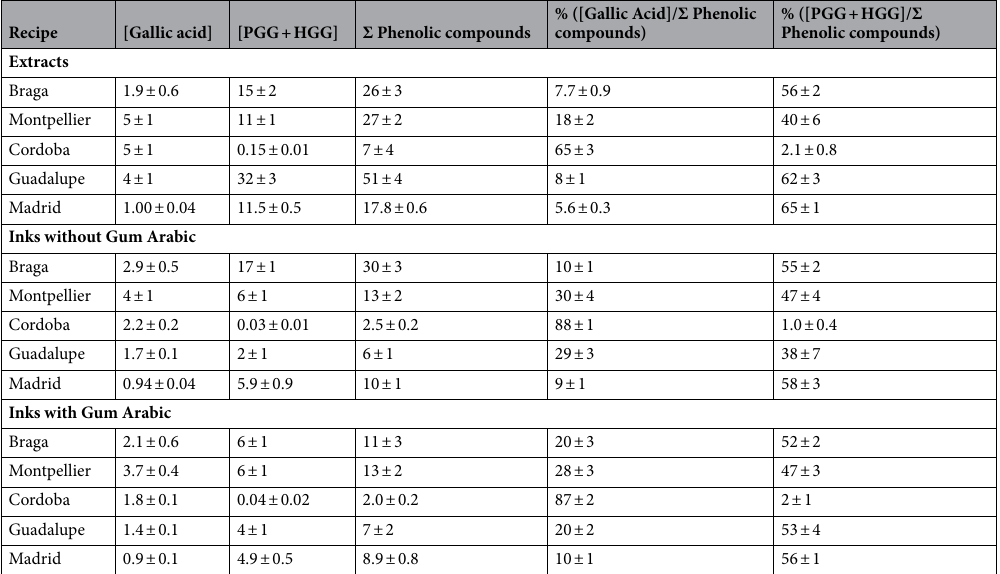
Table 4a. The pseudomolecular ion [M−H] − m/z 781 was tentatively identified as punicalin due to the MS 2 fragmenta- tion pattern m/z 721, 601 and 299 in agreement with was previously reported 23–25 . Punicalagin was tentatively identified as [M−H] − m/z 1083 with MS 2 fragments m/z 781 (punicalin), 601 and 301. The pseudomolecular ion m/z 301 corresponds to ellagic acid with MS 2 fragments m/z 257, 229 and 185 20 .